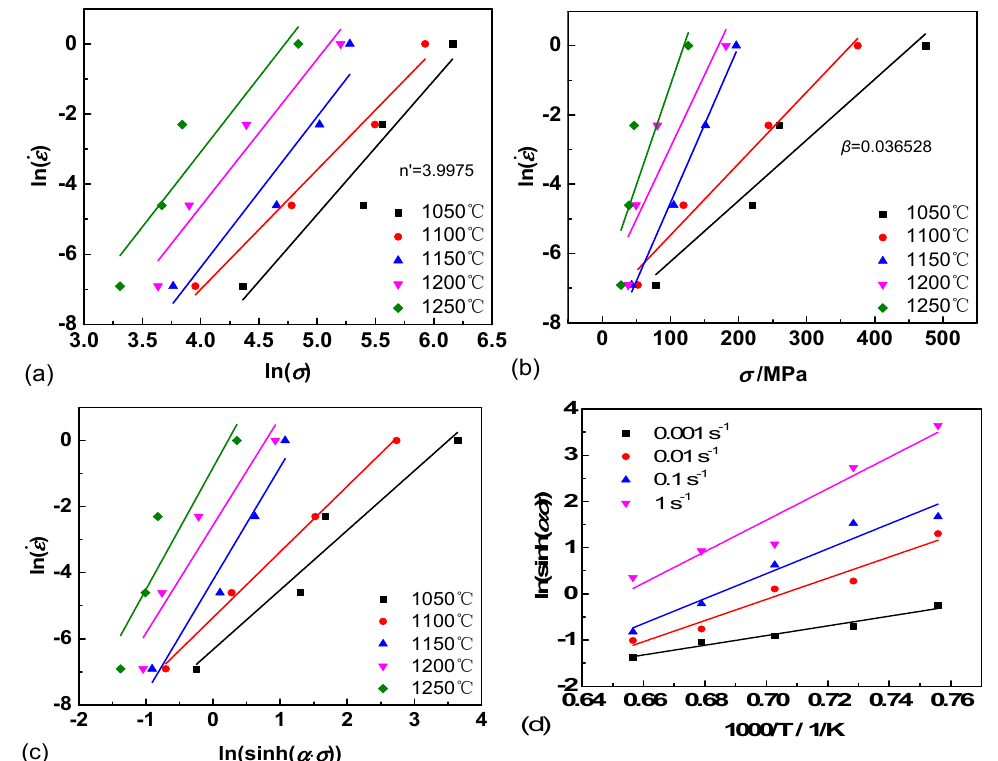
. . . ε -ln σ ; ( b ) ln ε - σ ; ( c ) ln ε -ln[sinh( ασ )] and ( d ) ln[sinh( ασ )]-1000/ T